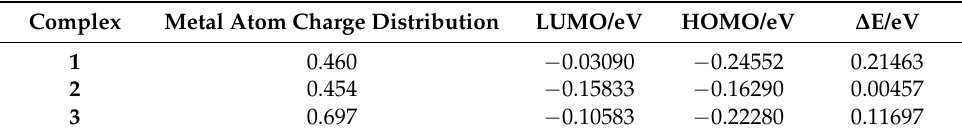
Figure 6. The electrostatic potential (ESP) of complex 3. Table 5. Metal atom charge distribution, highest occupied molecular orbital (HOMO), and lowest unoccupied molecular orbital (LUMO) of complexes 1 – 3.